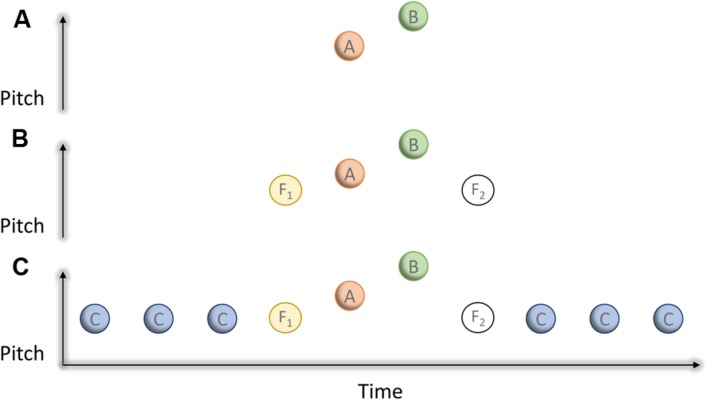
Arrangement of stimuli in the experiment of Bregman and Rudnicky (1975).
(A) Shows two stimuli—A and B—differing slightly in pitch. (B) Shows the case where two stimuli (flankers) of identical pitch—F1 and F2—flank the AB pair. (C) Shows the case in which a sequence of stimuli—the captor C stimuli—precede and follow the flanker stimuli. The flankers and captors share pitch and timing.